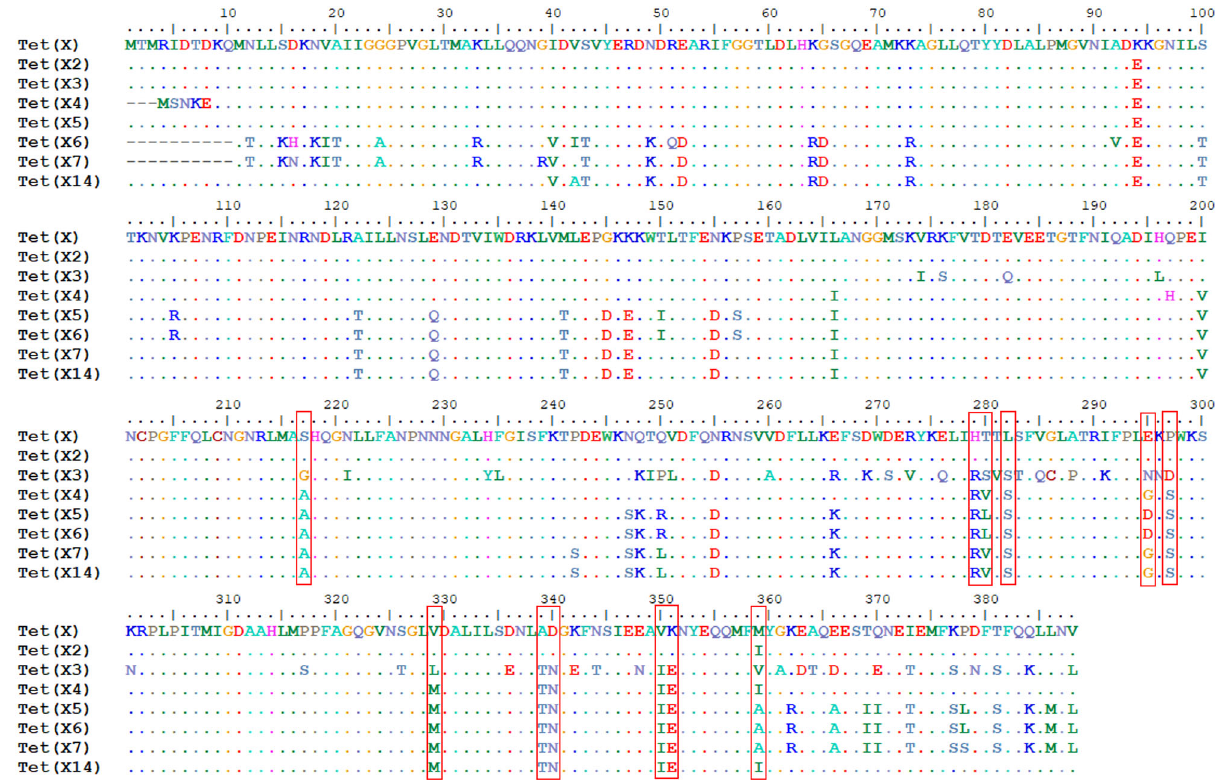
Fig. 1 Alignment of the complete amino acid sequences encoded by Tet (X) variants genes using BioEdit. Amino acid residues are depicted in different color, the same amino acid is shown as dots in the alignment. Commonly mutated sites in Tet(X3), Tet(X4), Tet(X5), Tet(X6), and Tet(X7) compared with original TetX protein are highlighted in red box.